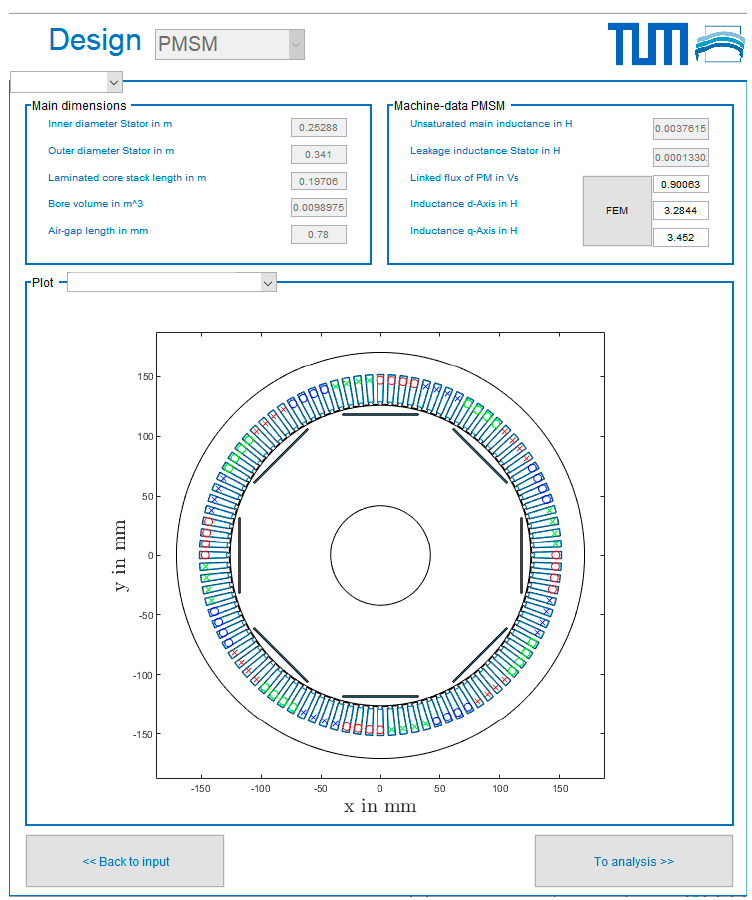
Figure 6. Results of the design process and representation of the geometry.